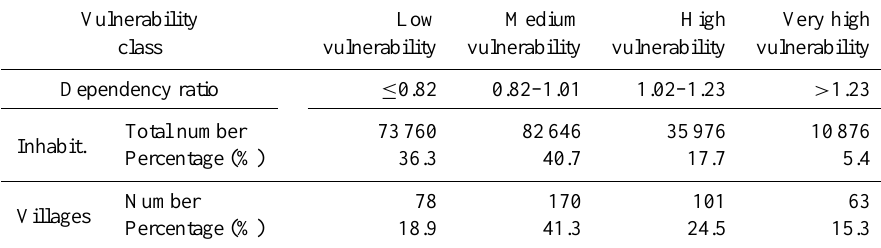
Table 3. Synthetic data of vulnerability factor 2 in Tutova Hills. Vulnerability Low